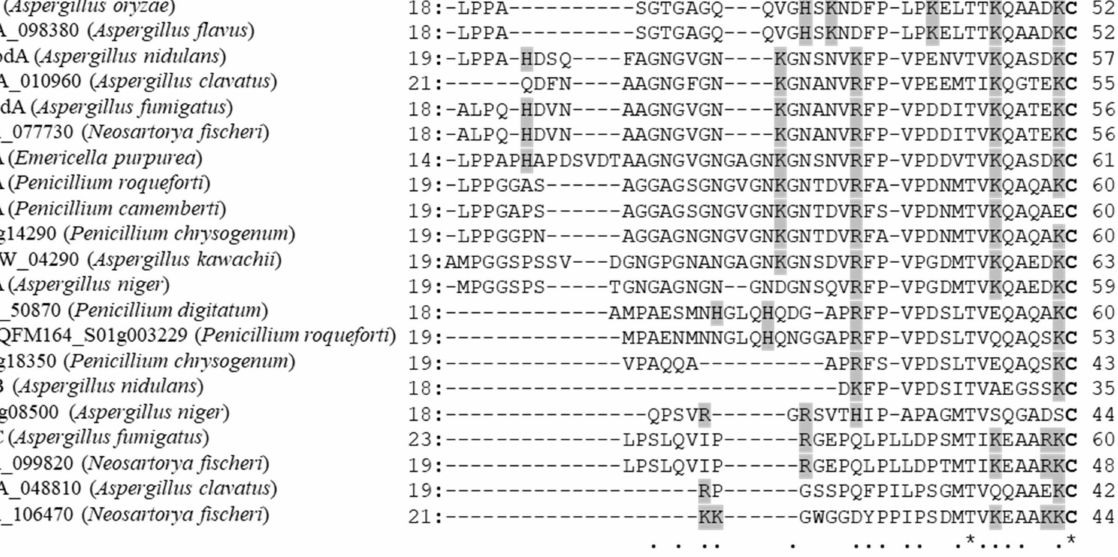
Figure 5. N-terminal regions of hydrophobins in the clade containing AnRodA and RolA (as in [8]). Identical residues are indicated by asterisks, and highly conserved residues are indicated by periods. Positively charged residues (Arg, His, and Lys) are shaded in gray. Cys residues are shown in